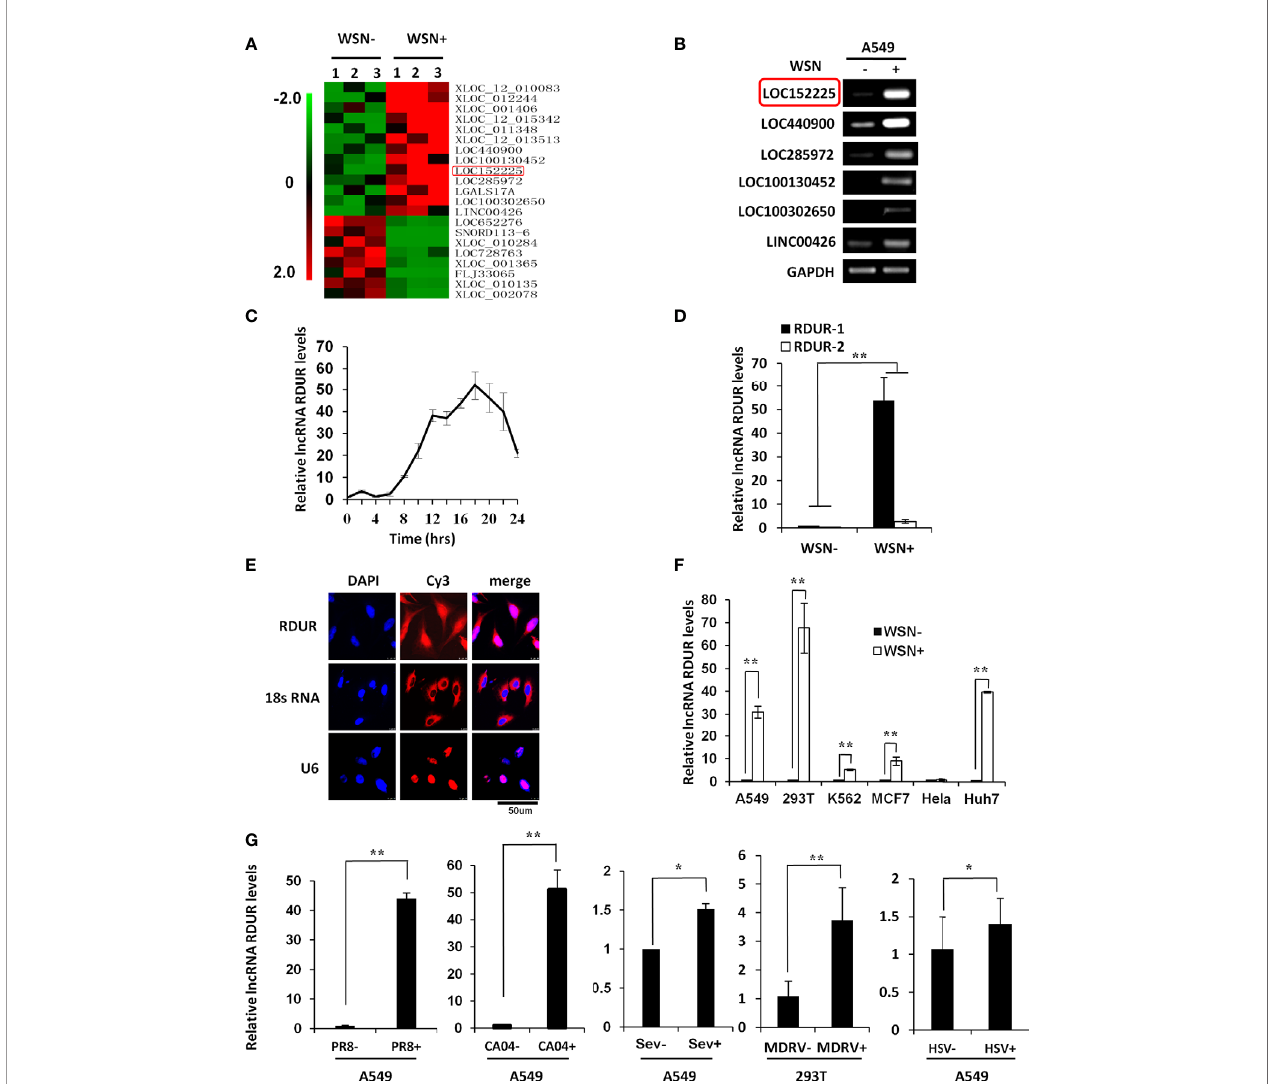
FIGURE 1 | Human RDUR is identi fi ed as a new lncRNA induced by in fl uenza A virus and several other viruses. (A) The differentially expressed lncRNAs in A549 cells infected with or without A/WSN/33 in fl uenza virus (WSN) were analyzed by a cDNA microarray (http://www.ncbi.nlm.nih.gov/geo/; GEO access number GSE58741). Shown are representative differentially expressed lncRNAs. (B) A549 cells infected with WSN were collected at 16 h post-infection (hpi). The differential expressions of 6 selected lncRNAs were con fi rmed by RT-PCR. RDUR (LOC152225) is indicated by red rectangle. (C) Quantitative real-time PCR (qRT-PCR) was performed to examine the kinetics of RDUR expression in WSN infected A549 cells (n = 3; means ± SD). (D) Shown is the abundance of two isoforms of RDUR examined by qRT-PCR. The error bars represent the SD. Shown are representative results from three independent experiments. (E) RNA-FISH was performed to determine the localization of RDUR in WSN infected A549 cells. Shown were representative images from at least three independent experiments with similar results. (F) RDUR expression was examined by RT-PCR in indicated human cell lines infected with WSN (moi=1) for 16 h. Plotted are the average results from three independent experiments. Data are shown as means ± SD. ** P < 0.01. (G) RDUR expression was examined by qRT-PCR in indicated cells infected with in fl uenza viruses (PR8 and CA04), Sendai virus (SeV), Muscovy duck reovirus (MDRV), or herpes simplex virus type 1 (HSV-1). Plotted are the average results from three independent experiments. Data are shown as means ± SD. * P < 0.05, ** P <